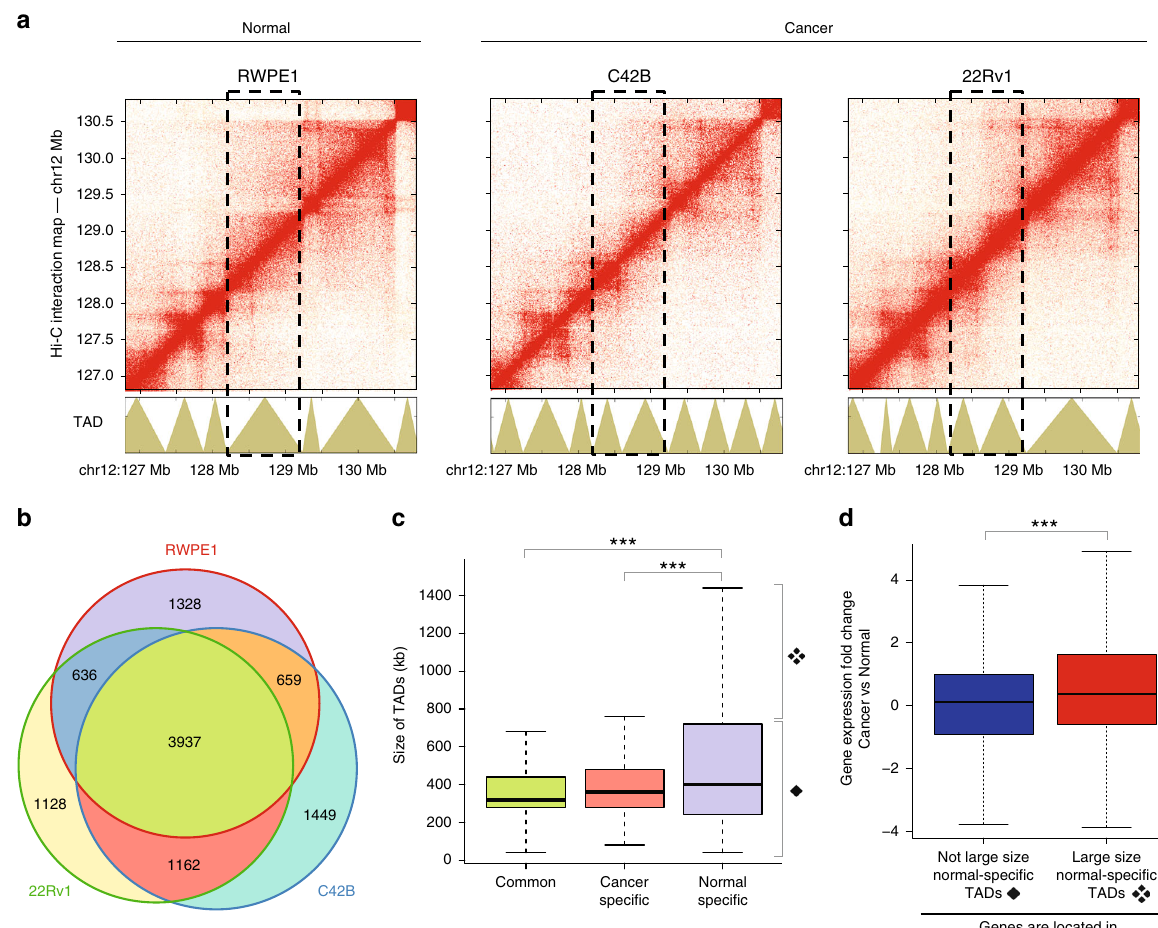
Fig. 1 Changes in TAD boundaries leads to alterations in prostate cancer transcriptome. a In situ Hi-C chromatin interaction maps of the region of chromosome 12q24 in normal (RWPE1) and prostate cancer (C42B, 22Rv1) cells. Red indicates more frequent interactions and white indicates no interactions. TADs identi fi ed using the TopDom program 14 are shown at the bottom. Dashed lines indicate the position of a single TAD in RWPE1 cells, which forms two TADs in the cancer cells. b A Venn diagram showing the overlap of TADs found in the three cell lines. c Shown is the size of common ( n = 3937), normal-speci fi c ( n = 1328), and cancer-speci fi c ( n = 1162) TADs. d Expression fold change between cancer (C42B) and normal (RWPE1) cells of genes that are located in large size normal-speci fi c TADs (red, see the symbol ❖ to the right side of graph in c ) and not large size normal-speci fi c TADs (blue, solid diamond ♦ ) (Wilcoxon rank sum test, *adj. p value < 0.05, **adj. p value < 0.01, ***adj. p value <